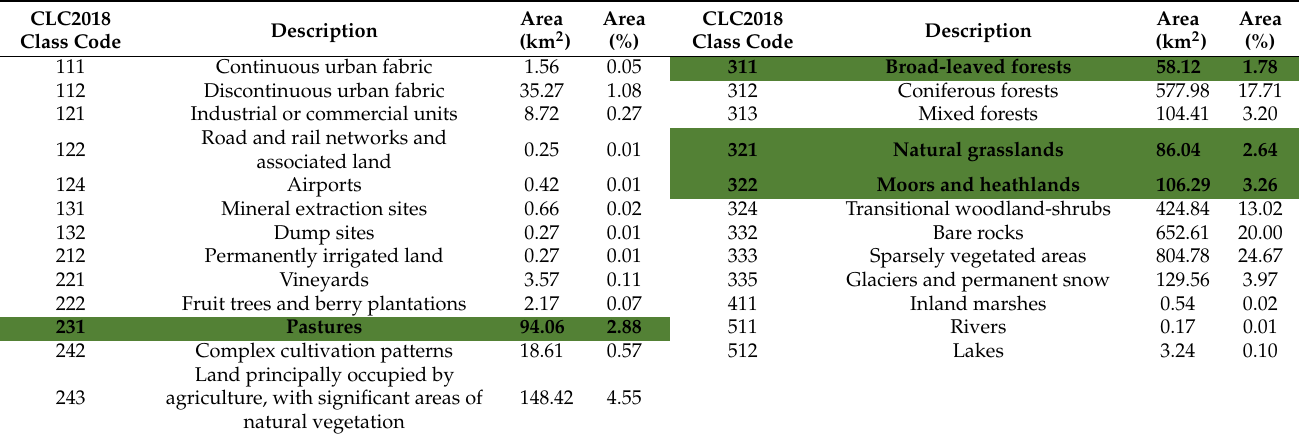
Table 2. CORINE land cover 2018 dataset (CLC2018) Level 3 classes and corresponding areas in Aosta Valley. In green, classes that were considered to represent rangelands and broad-leaved forests.